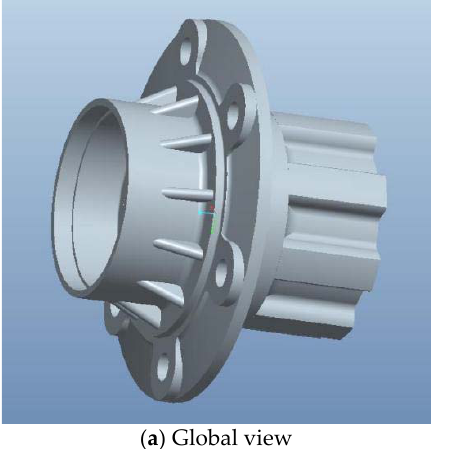
Figure 4. Simplified 3D model of the wheel hub. After the model is imported into the ANSYS software, the meshing is conducted. Concretely, through the Sizing function in the Mesh program, fine meshing is performed on the part where the stress is concentrated, i.e., on the installation rabbet, while sparse meshing is performed on the other parts that are slightly stressed or not stressed. The results of the meshing are exhibited in Figure 5. A total of 145,211 3D tetrahedral solid units and 244,181 nodes are divided.